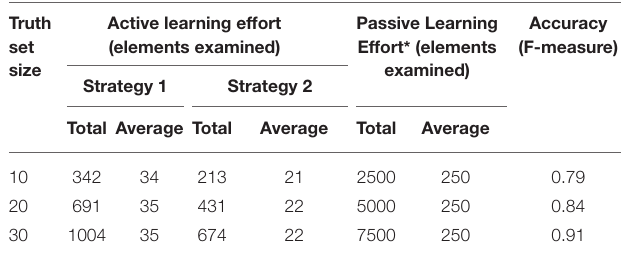
TABLE 2 | Impact of active-learning on user